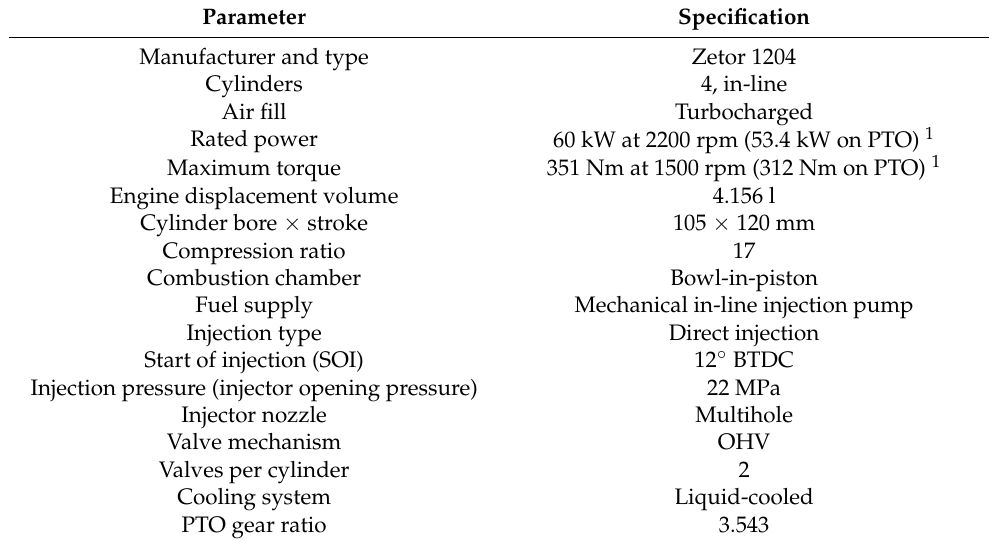
Table 2. Test engine specifications.